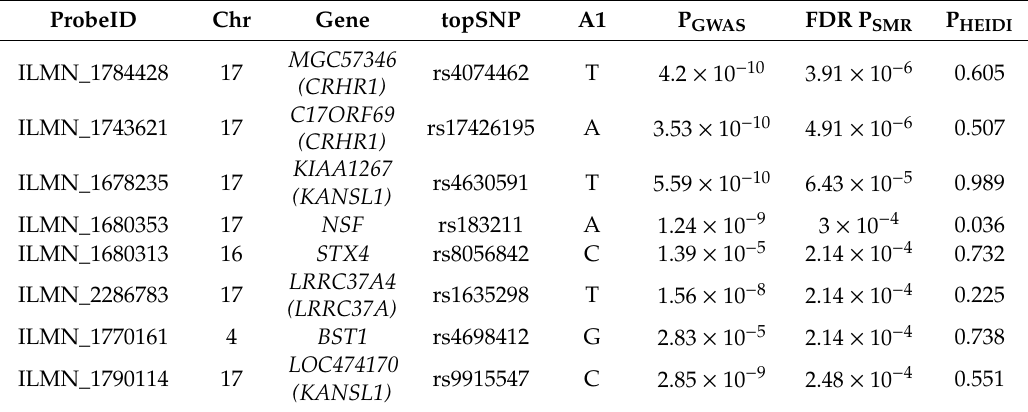
Table 1. Summary of risk genes identified by the summary data-based Mendelian randomization (SMR) and heterogeneity in dependent instruments (HEIDI) methods for PD.